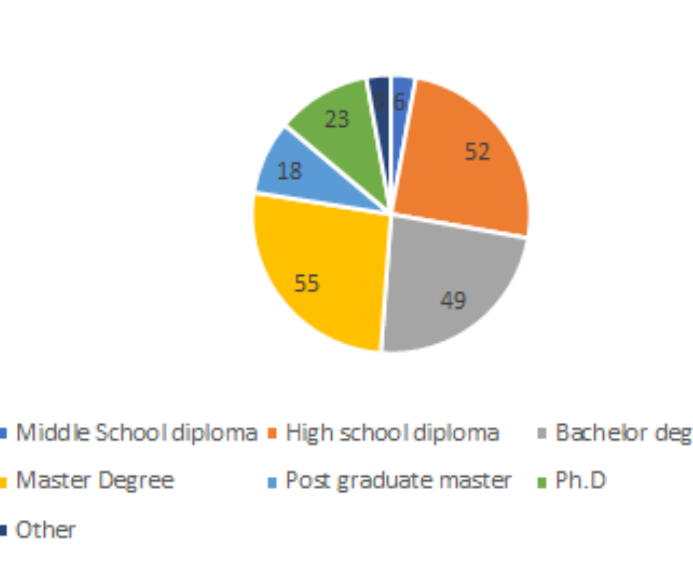
Figure 4. Respondents by education.